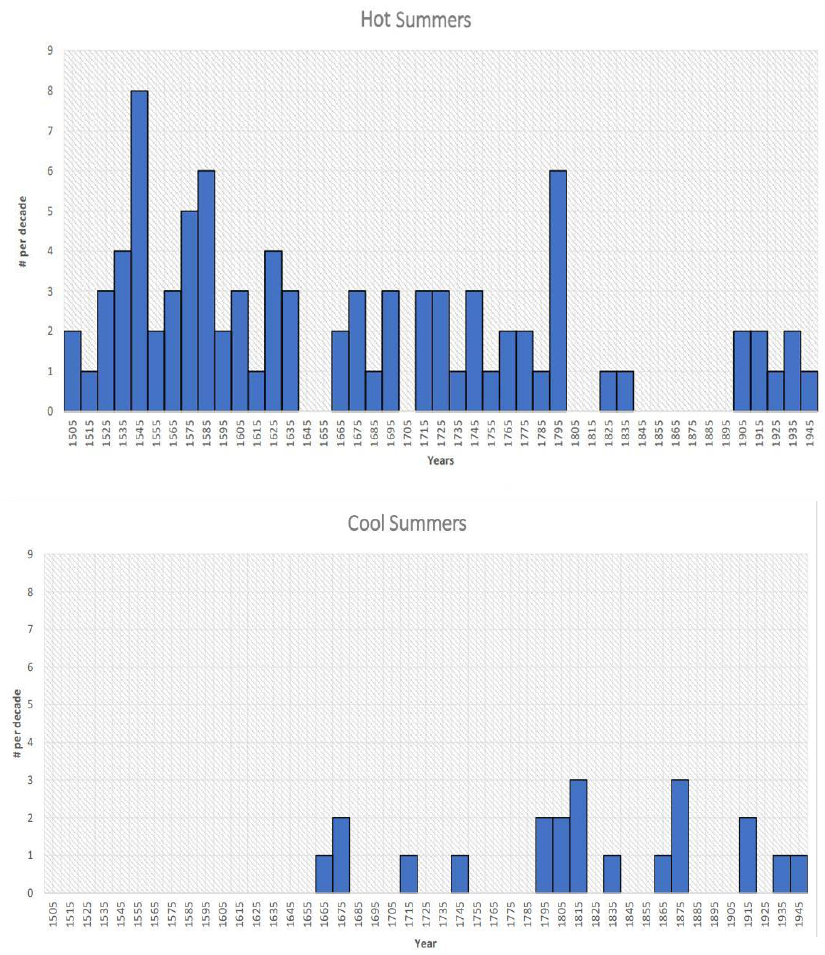
Figure 4. Decadal numbers of cool summers ( top ) and hot summers ( bottom ) in Transylvania for the period of 1500 to 1950.